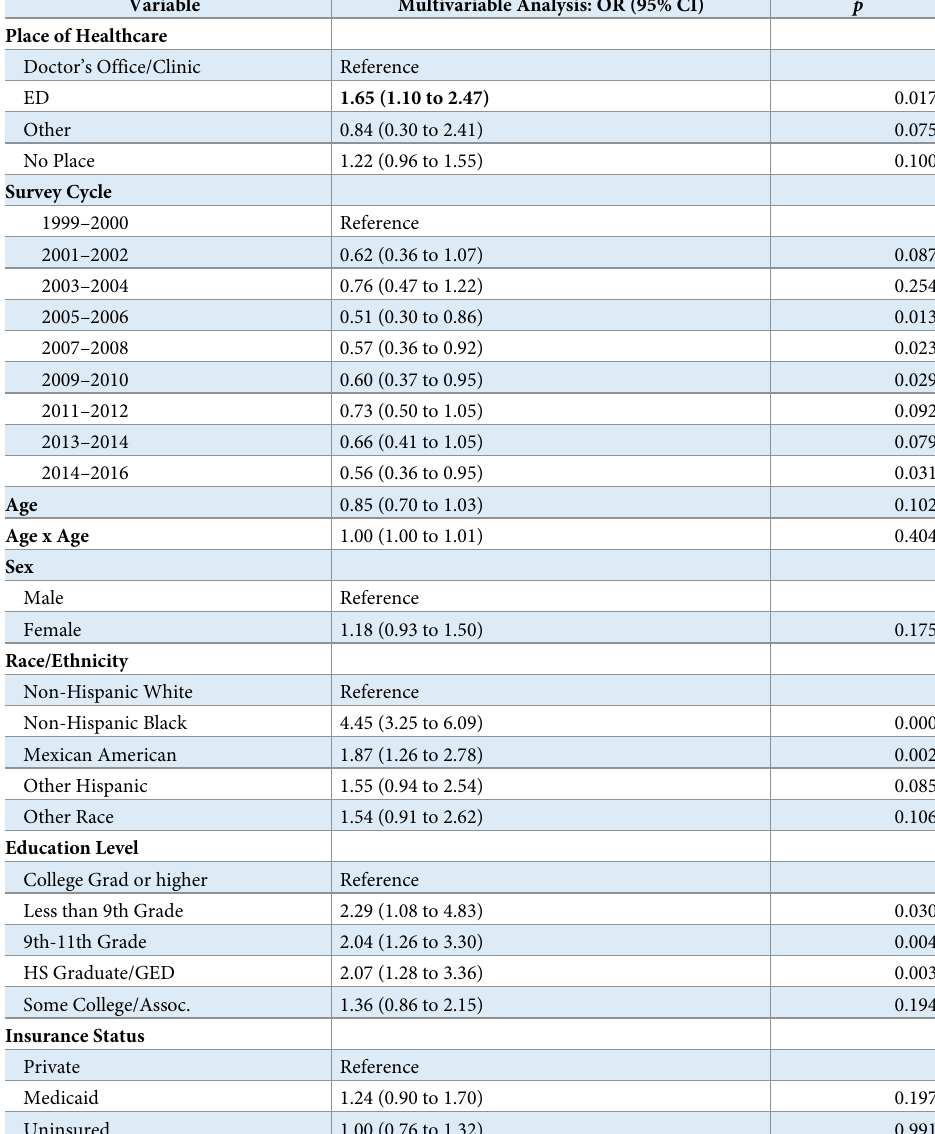
Table 3. Multivariable analysis of Chlamydia trachomatis urine samples among NHANES participants with sur- vey cycle, 1999 to 2016 (n = 19,275; N =